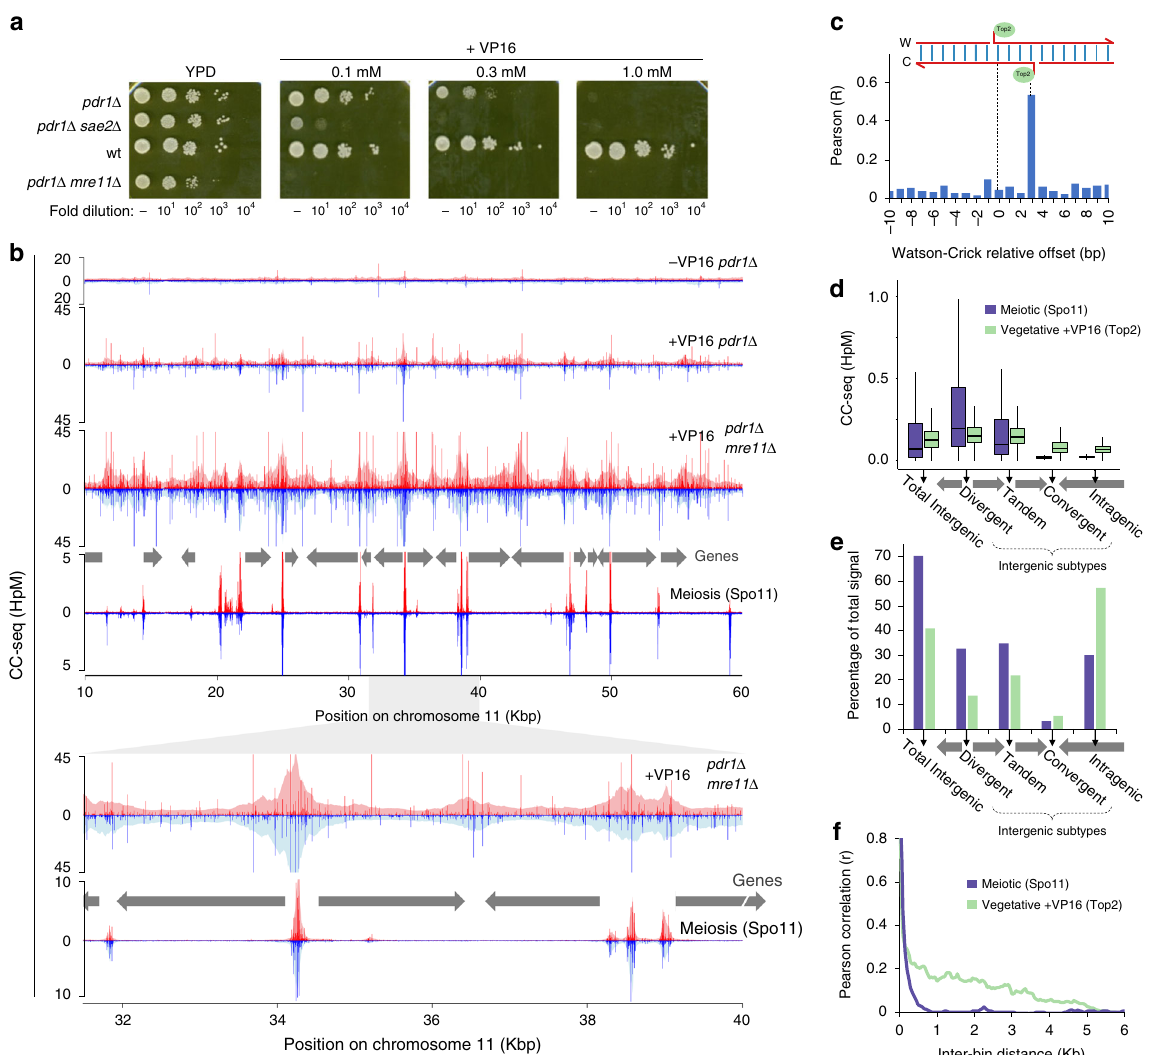
Fig. 2 CC-seq maps covalent Top2-linked DNA breaks in vegetative S . cerevisiae with nucleotide accuracy. a Serial dilution spot tests of VP16 tolerance for the indicated strains. b Nucleotide resolution CC-seq maps of vegetative S . cerevisiae Top2 CCs in the indicated strains after 4 h treatment with 1 mM VP16. Spo11 CC-seq data is plotted for comparison. Top2 CC-seq data were calibrated using a human DNA spike-in. Red and blue traces indicate CC-linked 5 ′ DNA termini on the Watson and Crick strands, respectively. Grey arrows indicate positions of gene open reading frames. Lower panels show an expanded view of the region from 31.5 to 40 Kbp. Pale shaded areas are the same data smoothed according to local density. c Pearson correlation (r) of Top2 ( pdr1 Δ ) CC-seq signal on Watson and Crick strands, offset by the indicated distance. d Quanti fi cation of vegetative Top2 ( pdr1 Δ ) and meiotic Spo11 CC-seq signal, strati fi ed by genomic region. The genome was divided into intra and intergenic regions; the latter further subdivided into divergent, tandem and convergent based on orientation of fl anking genes. Spo11 and Top2 activity mapped by CC-seq is expressed as box-and-whisker plots of density (upper and lower box limit: third and fi rst quartile; bar: median; upper and lower whisker: highest and lowest values within 1.5-fold of the interquartile range). Wilcox p -values < 10 − 3 . e Aggregation of data shown in ( c ), expressed as the percentage of total mapped reads. f Local autocorrelation of Top2 ( pdr1 Δ ) or Spo11 CC-seq signals. Top2 or Spo11 CC-seq data were binned at 50 bp resolution and the Pearson correlation ( r ) calculated between bins of increasing separation. HpM Hits per million mapped reads per base